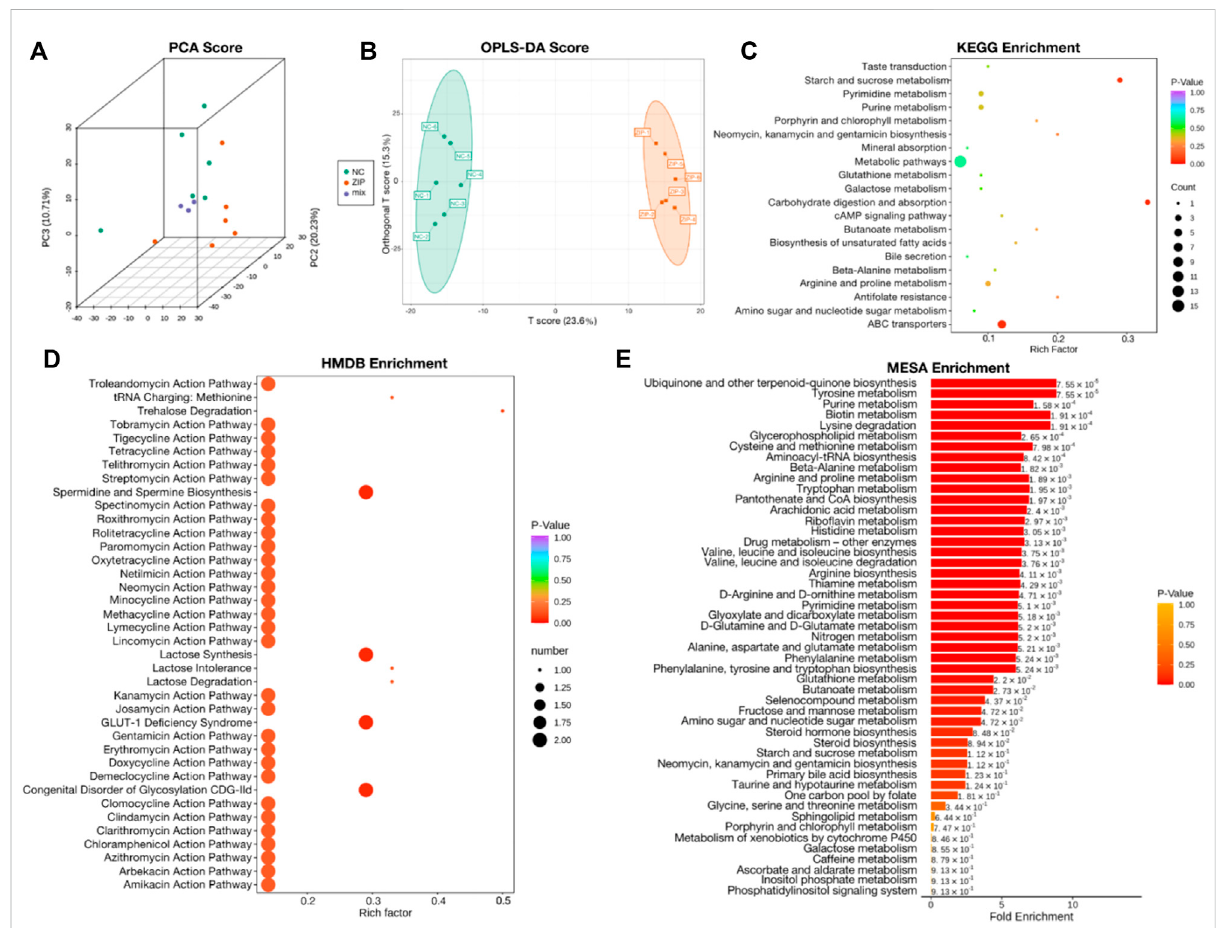
FIGURE 3 Metabolic analysisof SLC39A1-Overexpressed OSRC-2 cells. (A) Principal Component analysis (PCA) and (B) Orthogonal Partial Least Squares- DiscriminantAnalysis(OPLS-DA)scoreplotsbetweenNCandZIPgroups. (C) KEGGpathwayanalysisofmetabolomic data. (D) HMDBenrichmentof metabolic data. (E) MSEA enrichment of metabolic data. The label to the right of the column chart indicates p